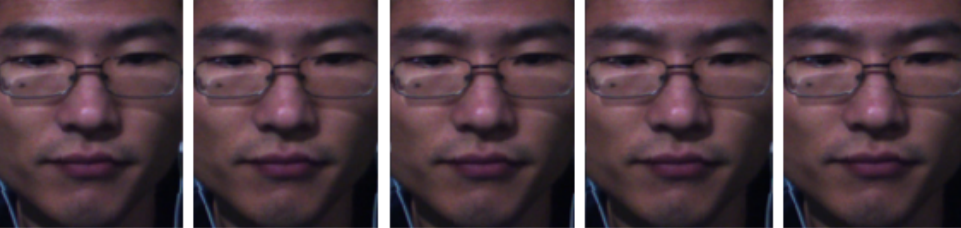
Figure 1. Sample micro expression from SMIC dataset